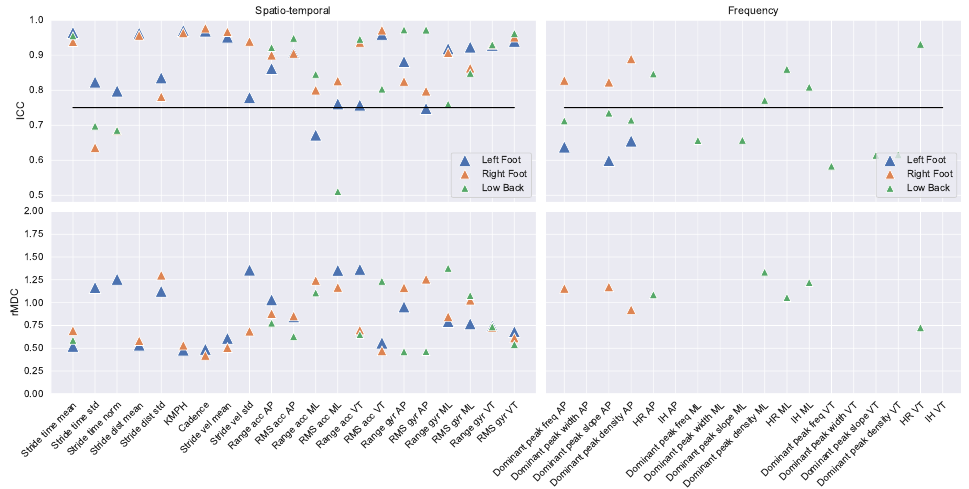
Figure 3. The ICC values (top panels) and rMDC values (bottom panels) of the spatio-temporal and frequency features for the left foot (blue triangle), the right foot (orange triangle), and the low back (green triangle). All outcomes above the horizontal black line were measured with good–excellent reliability. The exact outcomes of all gait features are provided in Table A1 in the Appendix A.